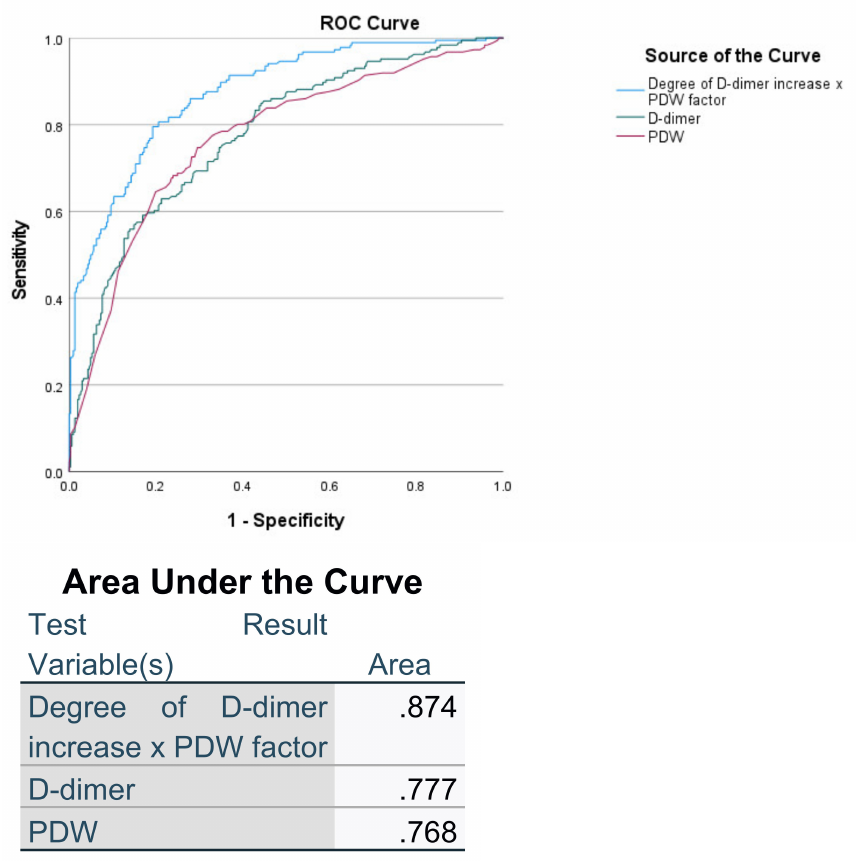
Figure 3. ROC curve comparing sensitivity and specificity of predicting the ARDS between PDW, D-dimer and